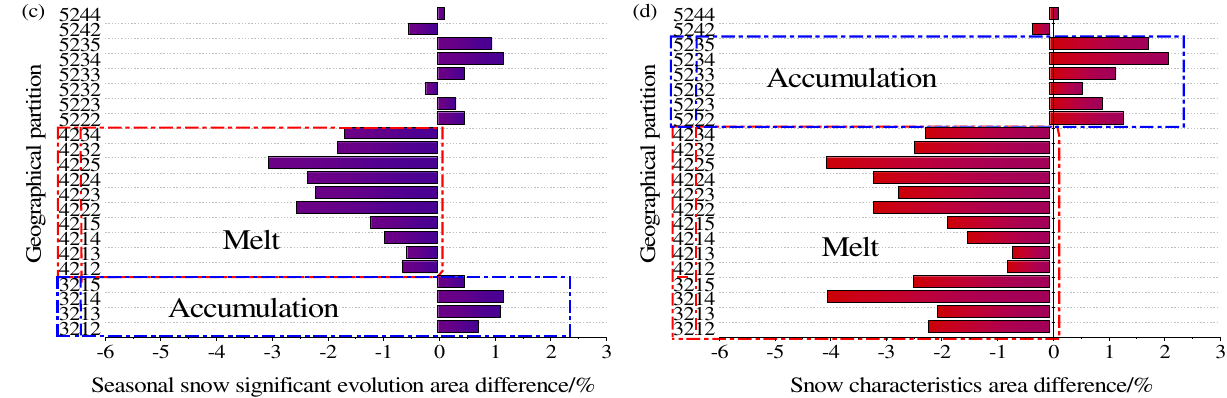
Figure 13. The evolutionary characteristics of snow in 22 geographical partitions of class